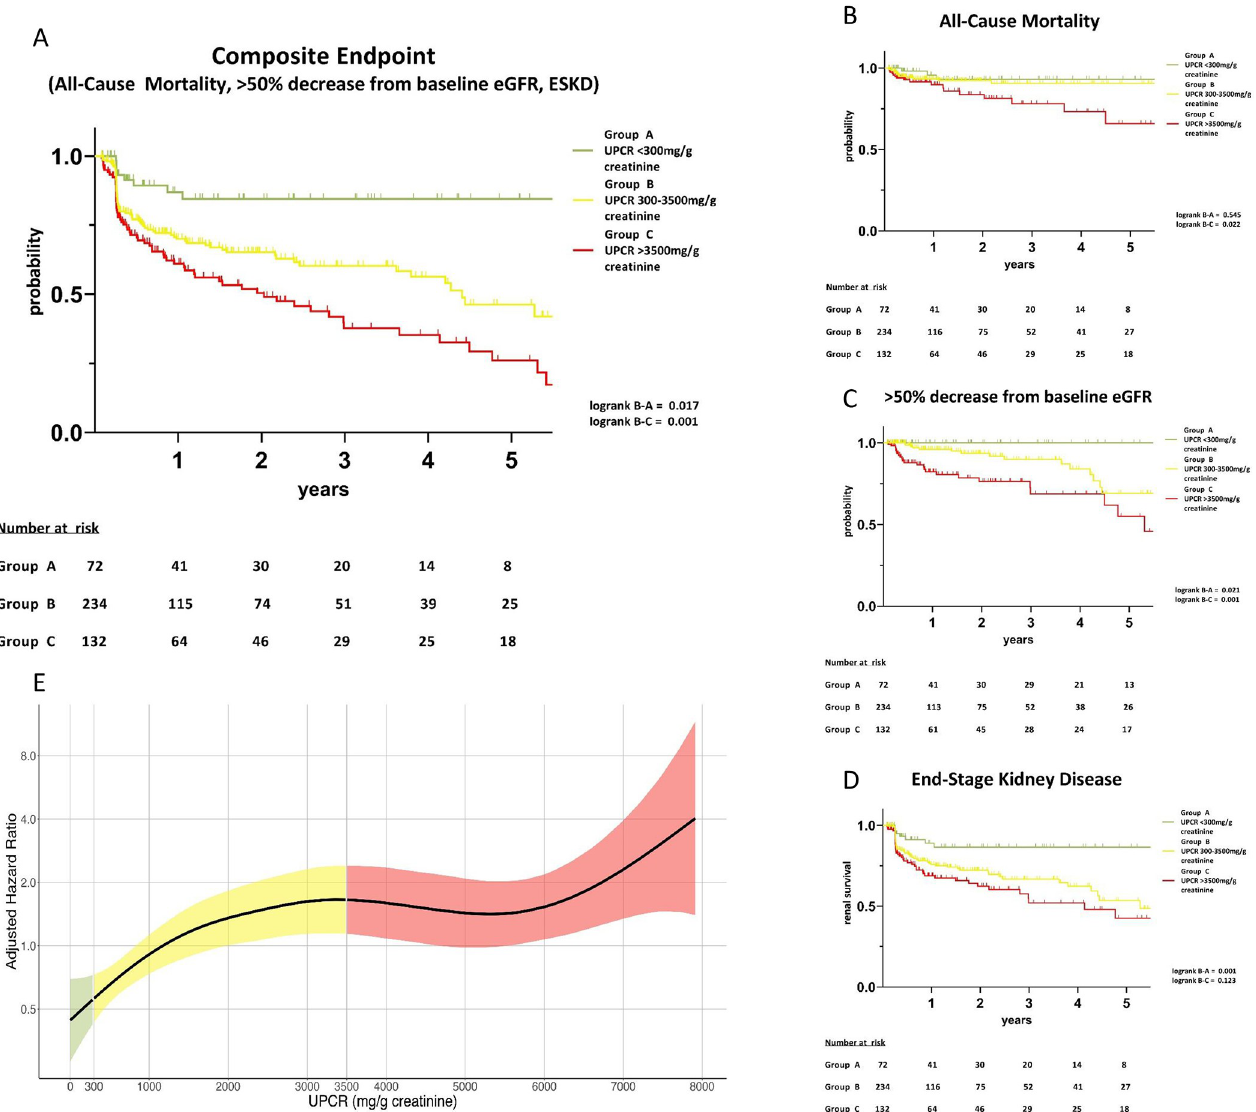
Fig 3. a Kaplan-Meier survival analysis regarding composite endpoint (all-cause mortality, decrease of eGFR by > 50% and ESKD) ESKD = end stage kidney disease. b Kaplan-Meier survival analysis regarding all-cause mortality end-stage kidney disease. c Kaplan-Meier survival analysis regarding > 50% decrease from baseline eGFR. d Kaplan-Meier survival analysis regarding ESKD. e Cubic spline curve analysis reflecting adjusted hazard ratios and UPCR UPCR urine protein creatinine